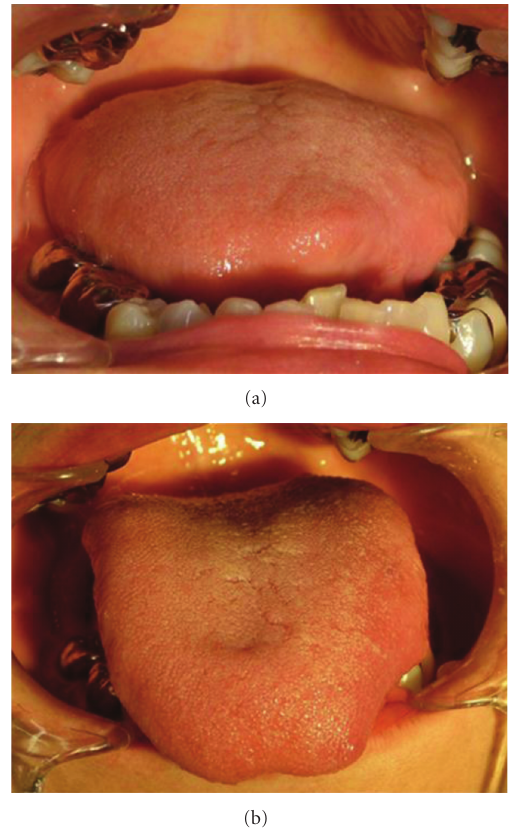
Figure 4: Postoperative intraoral view. The wound healed without any postoperative